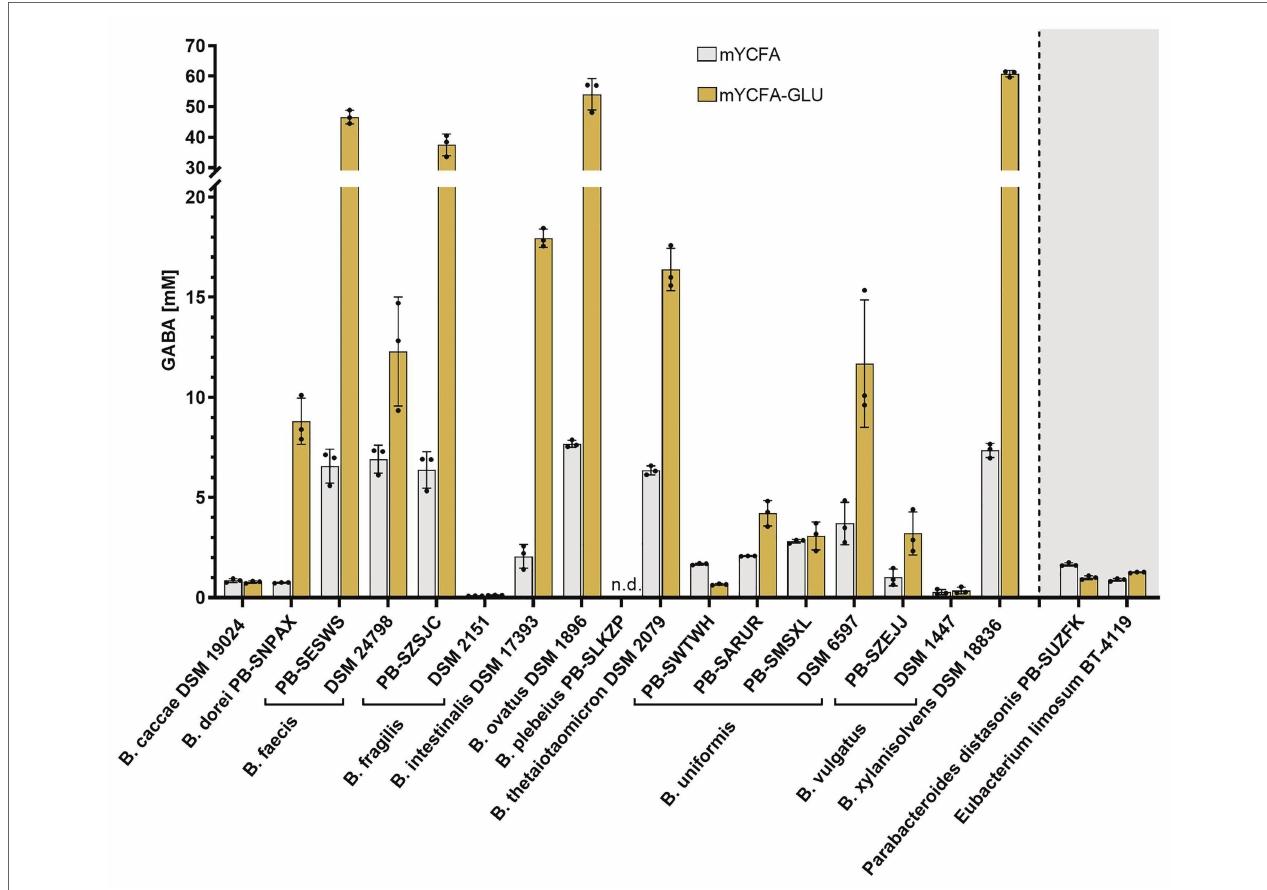
FIGURE 1 | γ -Aminobutyric acid (GABA) production by intestinal Bacteroides strains in the presence of two different glutamate concentrations. Bacteroides strains were incubated anaerobically at 37 ° C in mYCFA (8.38 ± 0.27 mM glutamate) and mYCFA-Glu (69.49 ± 1.10 mM glutamate) for 48 h ( n = 3). GABA quantified in the culture supernatant is displayed. Parabacteroides and Eubacterium strains were screened identically. Dots represent replicates; bars represent SD. GABA detection limit: 0.03 mM. n.d., not